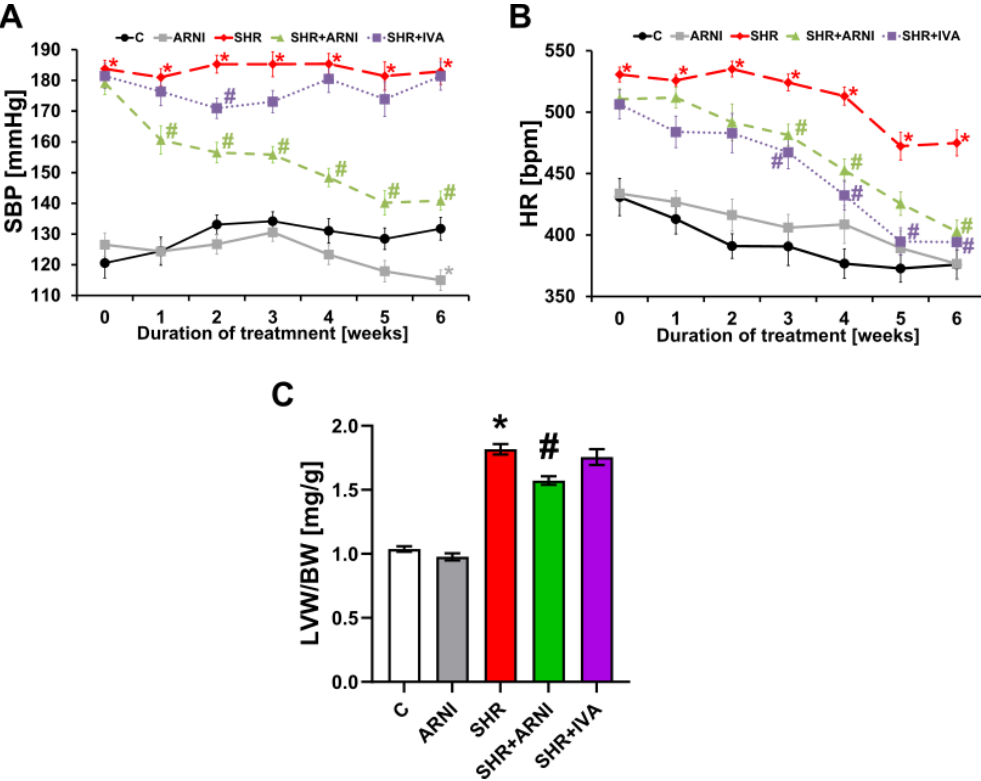
Figure 1. Effect of ARNI and ivabradine on systolic blood pressure (SBP) ( A ) and heart rate (HR) ( B ) throughout the experiment, and the relative weight of the left ventricle (left ventricular weight/body weight; LVW/BW) ( C ) in SHRs after six weeks of treatment. ARNI, sacubitril/valsartan; C, Wistar controls; IVA, ivabradine; SHRs, spontaneously hypertensive rats. Results are presented as means ± SEM. n = 15 per group. Repeated measures ANOVA ( A , B ) or one-way, two-tailed ANOVA ( C ) followed by multiple comparisons with a Bonferroni post-hoc test; * p < 0.05 vs. C; # p < 0.05 vs. SHR. The HR was 375.93 ± 11.61 bpm in the control group, and ARNI did not affect it after (474.95 ± 10.53 bpm, p < 0.05 vs. C), and ARNI and ivabradine decreased it ( p < 0.05) by 15% and 17%, respectively (Figure